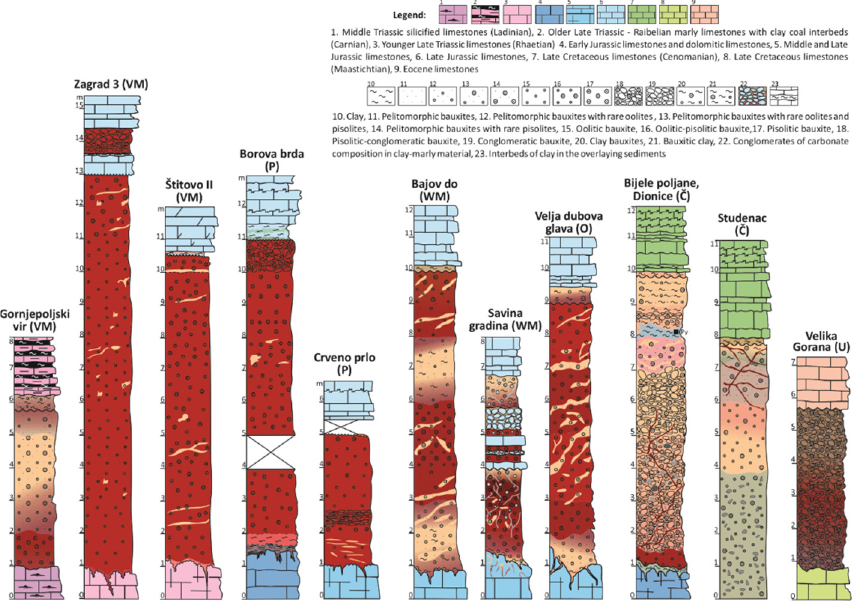
Figure 5. The geological sections of characteristic bauxite deposits/occurrences from different baux- ite formations of Montenegro (after Radusinovi ć [5] and REEBAUX project documentation, Radusi- novi ć